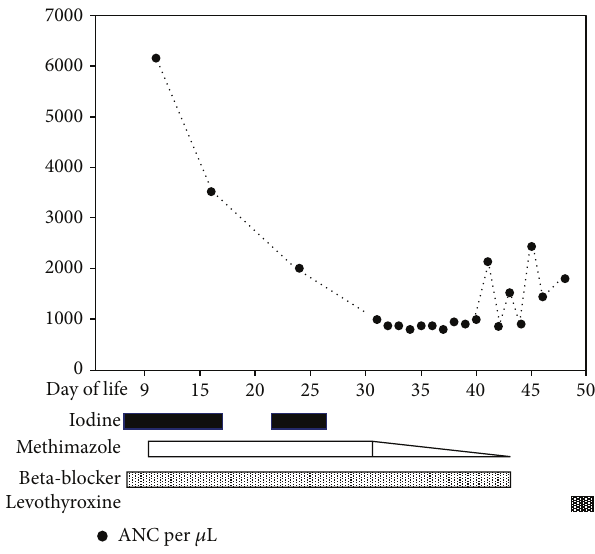
Figure2:Theabsoluteneutrophilcount(ANC)isshown.Neutrope- nia was noted after 20 days of methimazole use (DOL 30). Iodine, methimazole, beta-blocker, and levothyroxine are shown as bars at the end of the graph. The triangle at the end of methimazole bar represents the time it was